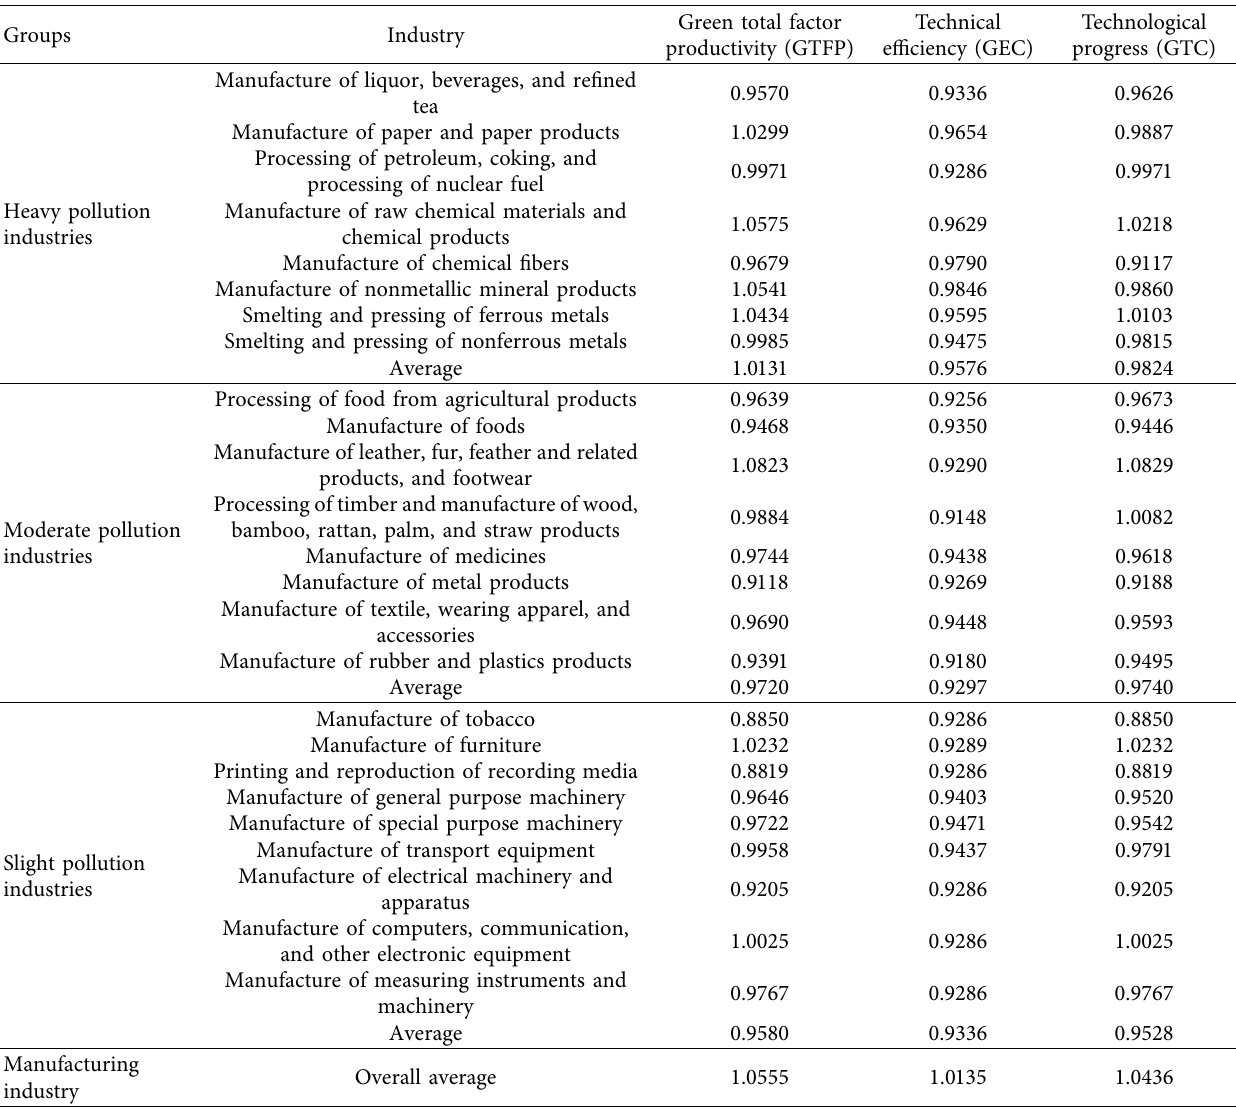
Table 4: Average GTFP and its decomposition in the industry from 2003 to